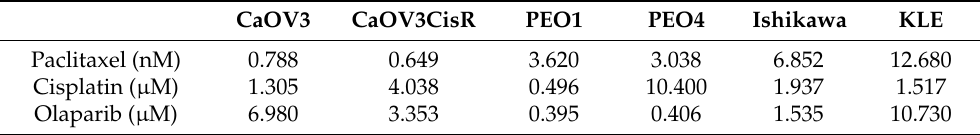
Table 1. IC70 doses of reagents (paclitaxel, cisplatin and Olaparib) used for the high-grade serous ovarian cancer cell lines CaOV3, CaOV3CisR, PEO1 and PEO4, and endometrial cancer cell lines Ishikawa and